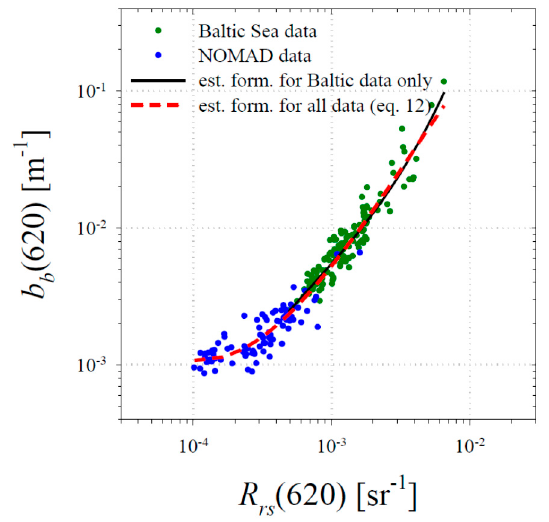
Figure 5. Relationship between the backscattering coe ffi cient b b and the remote sensing reflectance R rs at 620 nm. Data from the Baltic Sea and the NOMAD database are shown by green and blue points. The two lines show the best-fit polynomial relationships.